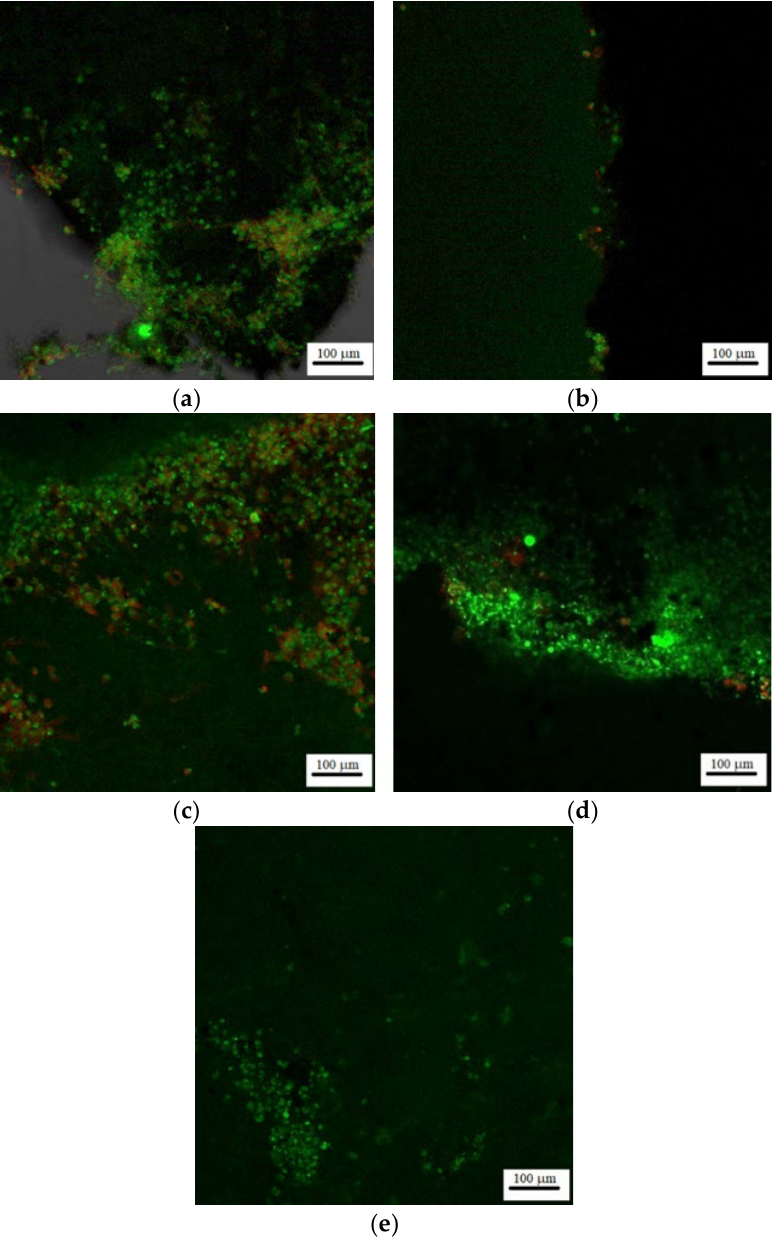
Figure 15. Florescence microscopy for images for F 1 ( a ), F 1 20s ( b ), F 2 ( c ), F 2 20s ( d ) and control ( e ) samples.